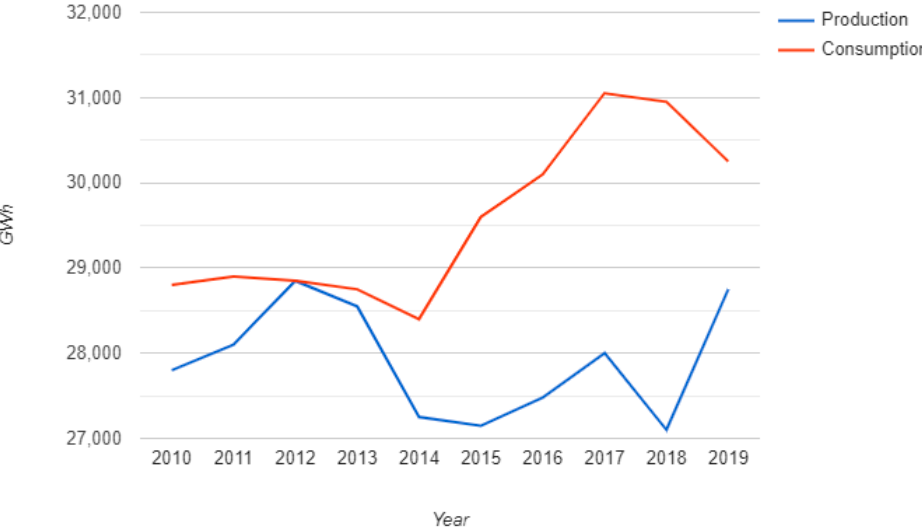
Figure 3. Annual production and consumption of electricity in Slovakia in the last 10 years [10].